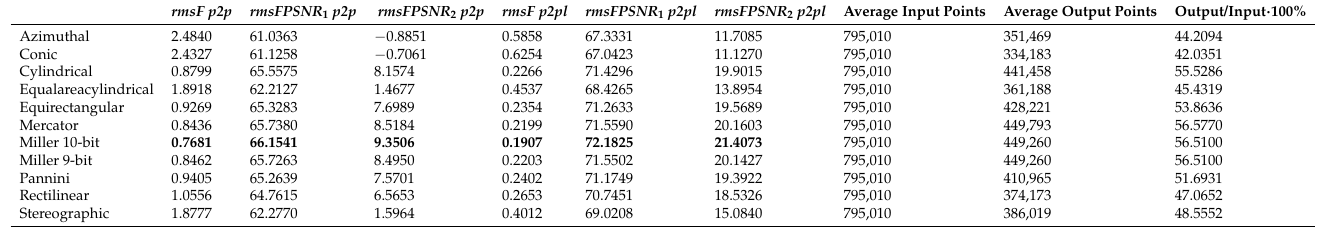
Table 6. Point-to-point (p2p) and point-to-plane (p2pl) objective measures rmsF , rmsFPSNR 1 and rmsFPSNR 2 , before Poisson reconstruction, using different projections with projection area of 1496 × 1344 pixels (approximately 2,000,000), best values are bold; average input and output number of points and their ratio.